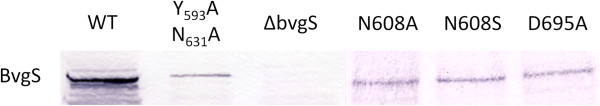
Detection of inactive BvgS variants in membrane extracts of the recombinant B. pertussis strains. The immunoblots were revealed using anti-BvgS polyclonal antibodies. The one-letter code was used to denote the substitutions. ΔbvgS represents BPSMΔbvgS from which bvgS has been deleted.